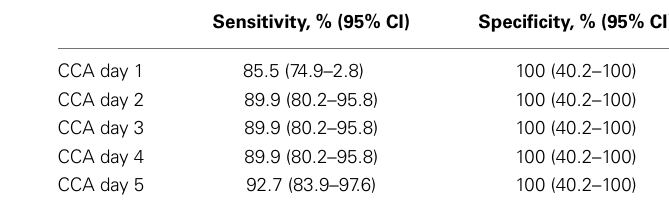
Table 3 | Sensitivity and specificity analysis of POC-CCA one day testing evaluated against a combined gold standard of at least 1 of 8 tests (5 POC-CCA and 3 Kato-Katz) being positive